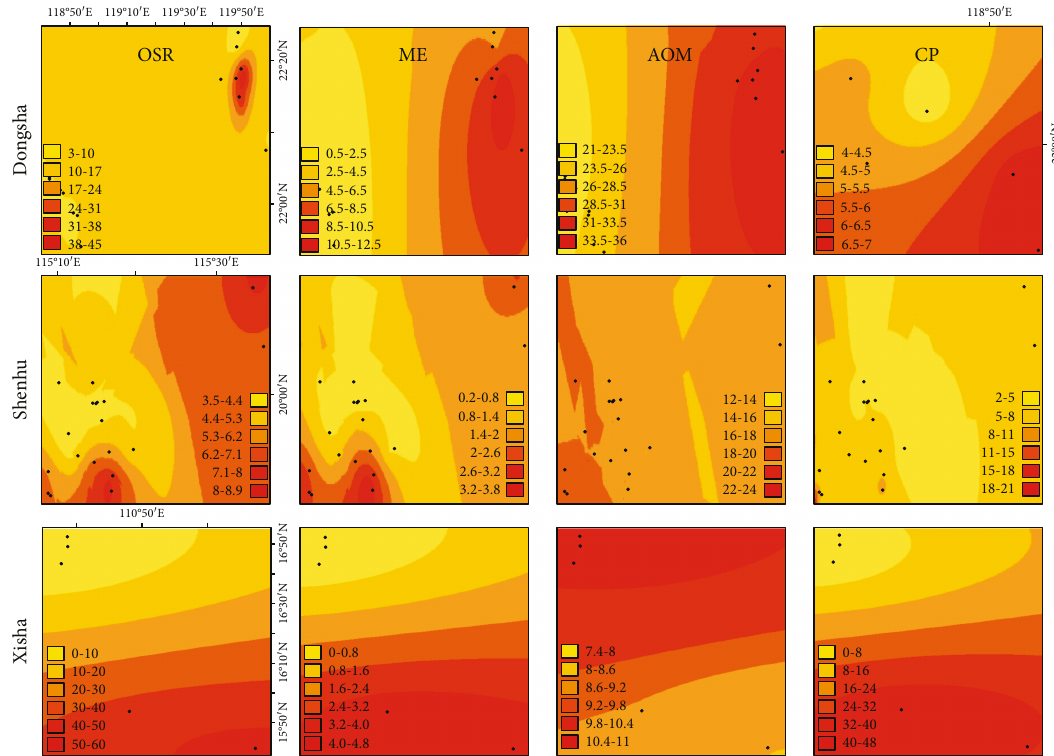
Figure 2: Spatial distribution of rates of organoclastic sulfate reduction (OSR), anaerobic oxidation of methane (AOM), methanogenesis (ME), and authigenic carbonate precipitation (CP) in the three areas. The black dots represent spatial distribution of sampling sites. Di ff erent colors denote di ff erent ranges of biogeochemical rates. In comparison to the interpolation rates of OSR, ME, and AOM in Dongsha, a smaller area was con fi ned in the interpolation rate of CP. Additionally, rates of OSR, ME, AOM, and CP have the same interpolation region and so do those in